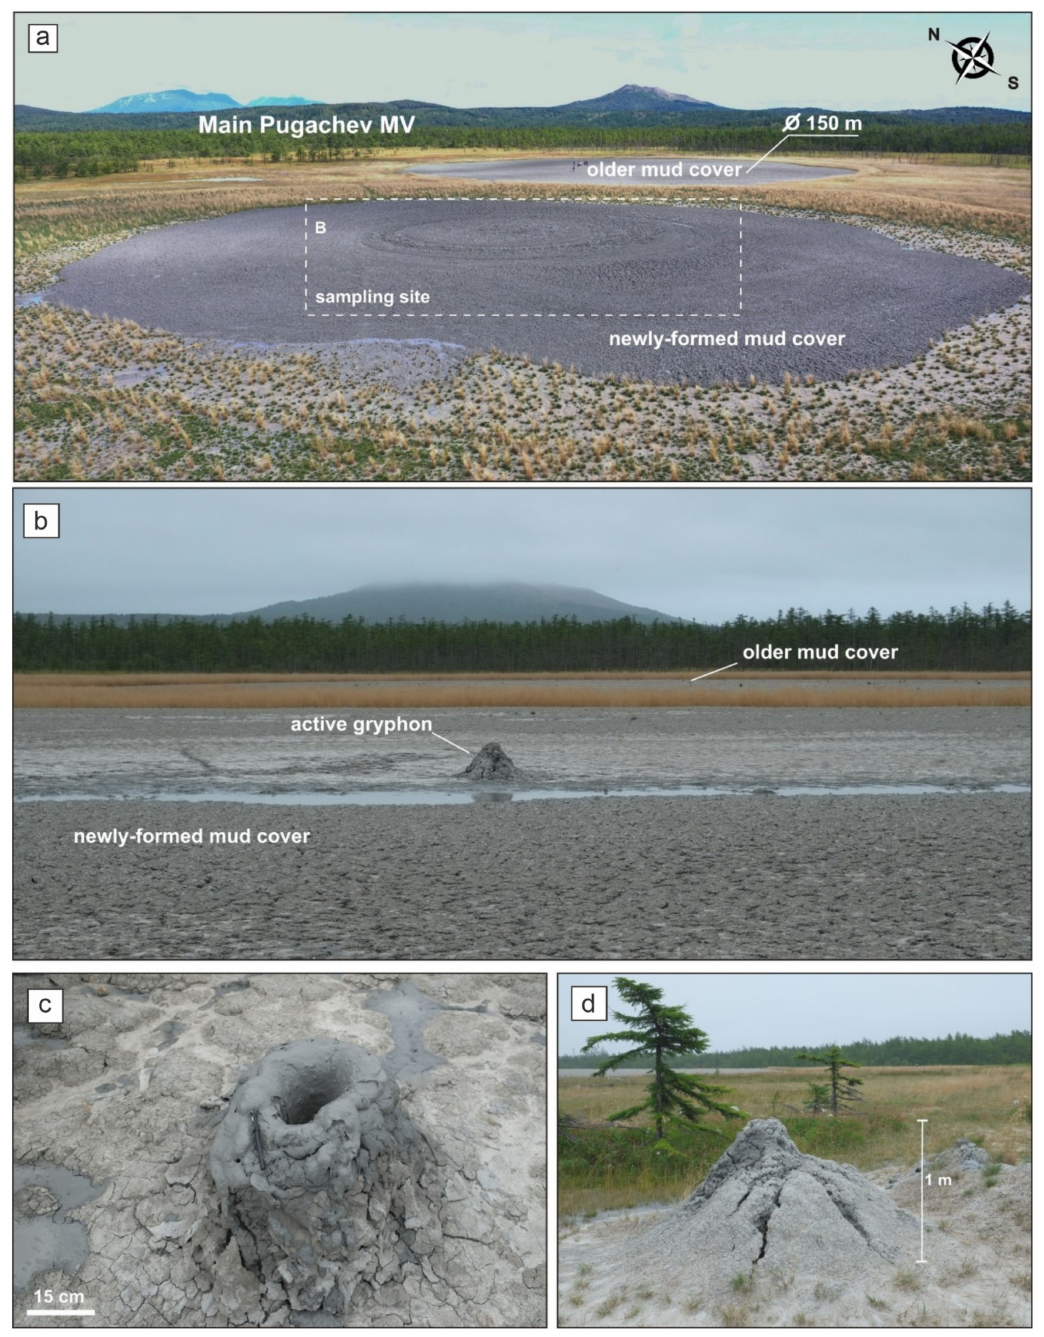
Figure 2. Pugachev mud volcanic field. ( a ) Main Pugachev mud volcanoe (MV) (48.2293 ◦ N; 142.5629 ◦ E), panoramic view. ( b ) Sampling site: Main Pugachev MV extruding viscous mud (September 2018). ( c ) Bubbling gryphon upon a newly formed mud cover (September 2018). ( d ) Active gryphon upon a weathered mud cover on the periphery of MV field (September